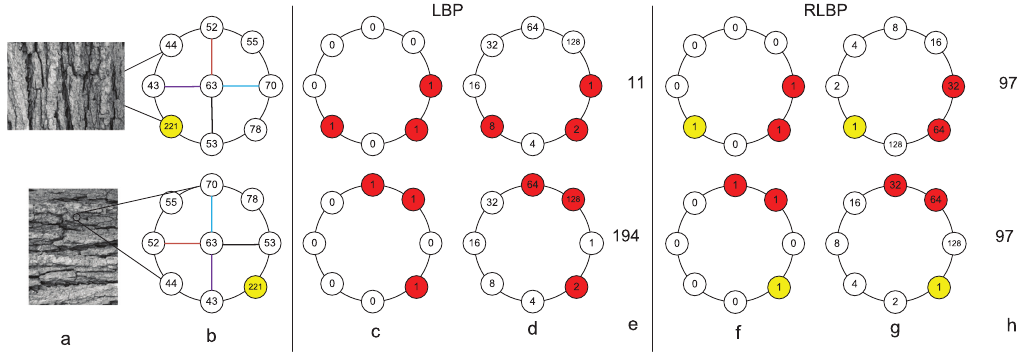
Figure 7. Rotation effect on LBP and RLBP descriptors: ( a ) original image and its rotated version, ( b ) Illustration of the neighbors rotation for the same pixel ‘63’, ( c ) Thresholded neighbors, values above threshold are shown in red color, ( d ) The weights corresponding to the thresholded neighbors, ( e ) LBP values, ( f ) Thresholded neighbors for RLBP with reference denoted in yellow color, ( g ) The weights of the thresholded neighbors, ( h ) The RLBP values for the original and rotated image is same